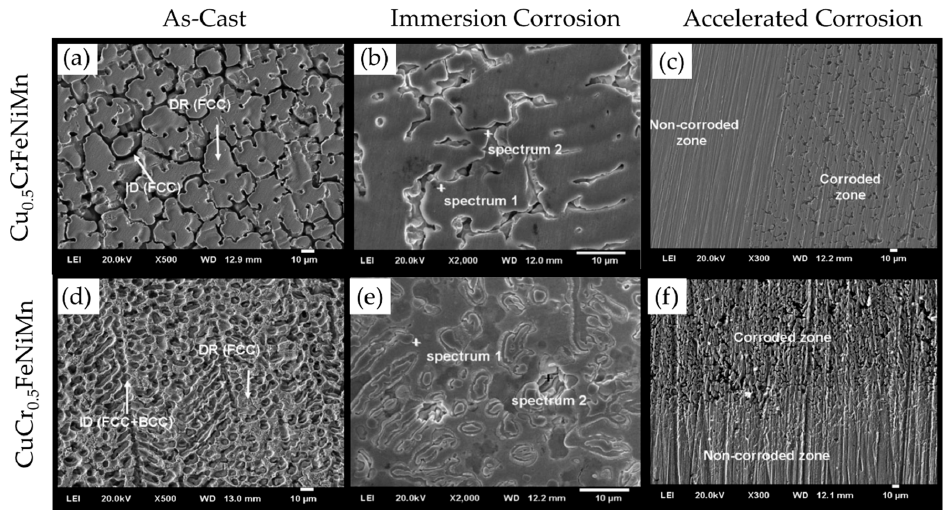
Figure 14. ( a , d ) Typical microstructures of Cr 0.5 CuFeMnNi and CrCu 0.5 FeMnNi system, respectively; ( b , e ) after immersion test in 1 M H 2 SO 4 and ( c , f ) after polarization test in 1 M H 2 SO 4 [44] (reprinted with permission from Wiley).